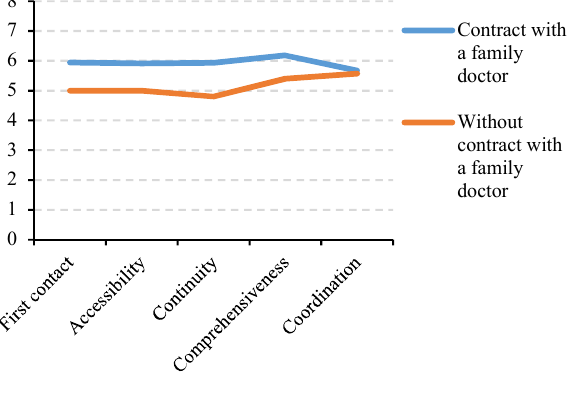
Figure 4. Perception score on the quality of primary healthcare attributes reported by participants.